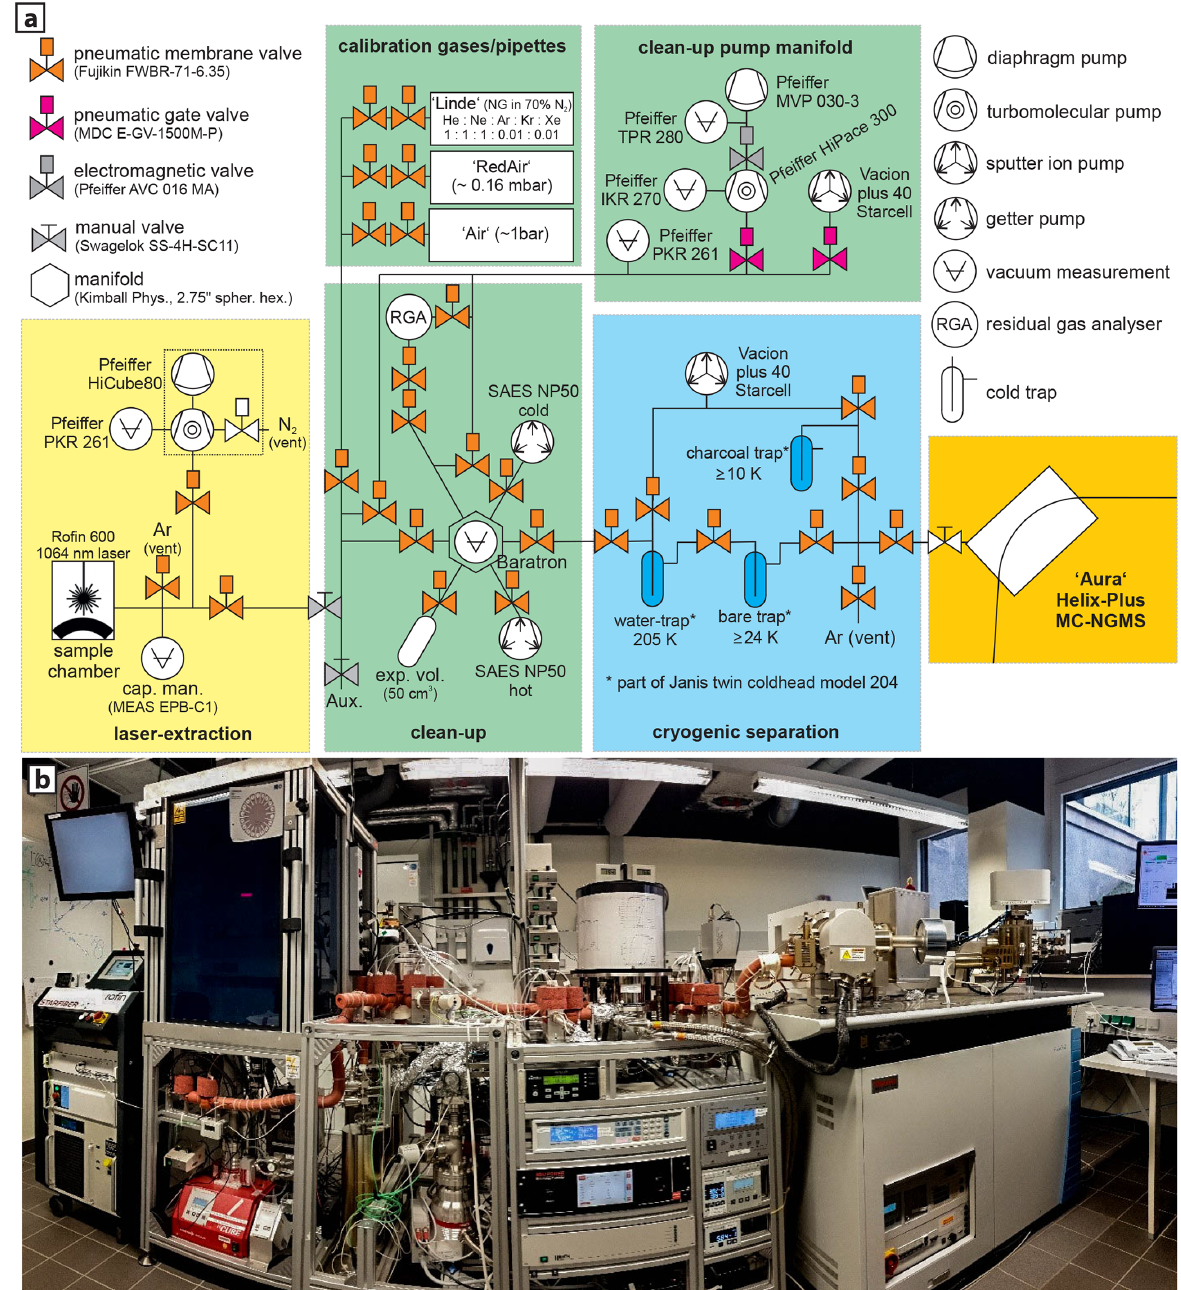
Figure 1. (a) Schematic plan and (b) picture of the noble gas extraction and purification line at the University of Cologne. From left to right: Rofin Starfiber 600, full-protection laser cage (laser protection windows P1P10, Laservision) housing the laser extraction, clean-up unit, cryogenic separation unit and the Helix Plus NG-MCMS “Aura”. The laboratory is temperature-stabilised to ± 0.5 ◦ C. Further description is provided in the